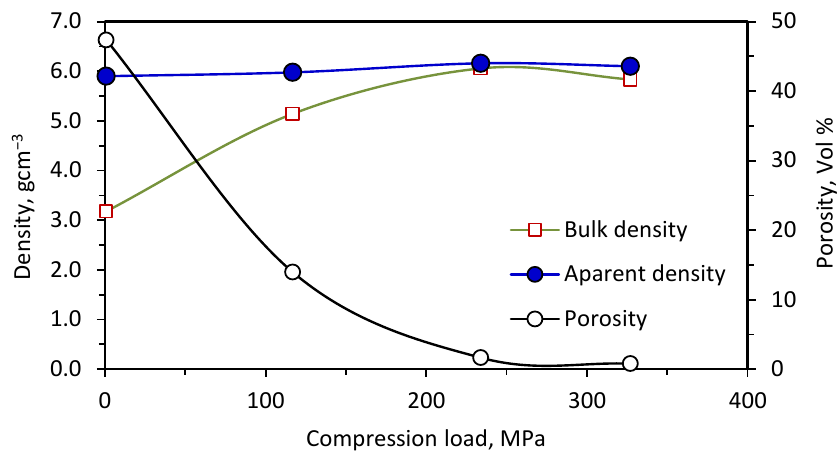
Figure 8. Effect of compression load on the 20 wt% ZrO 2 - samples’ porosity, bulk and apparent den- sities.